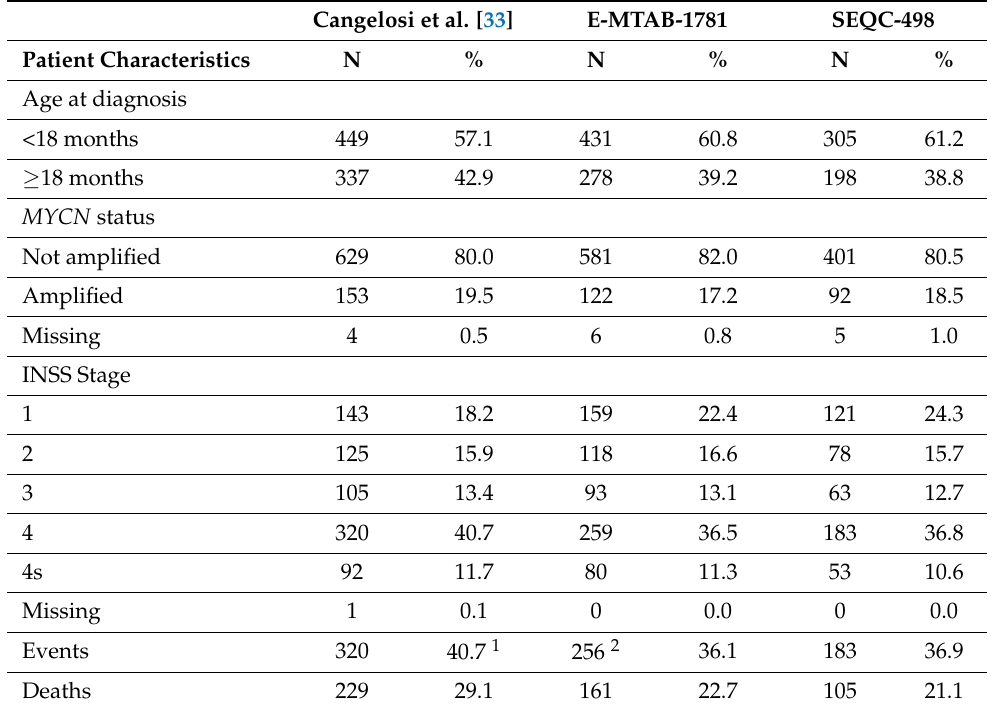
Table 1. Main characteristics of the datasets used to perform the